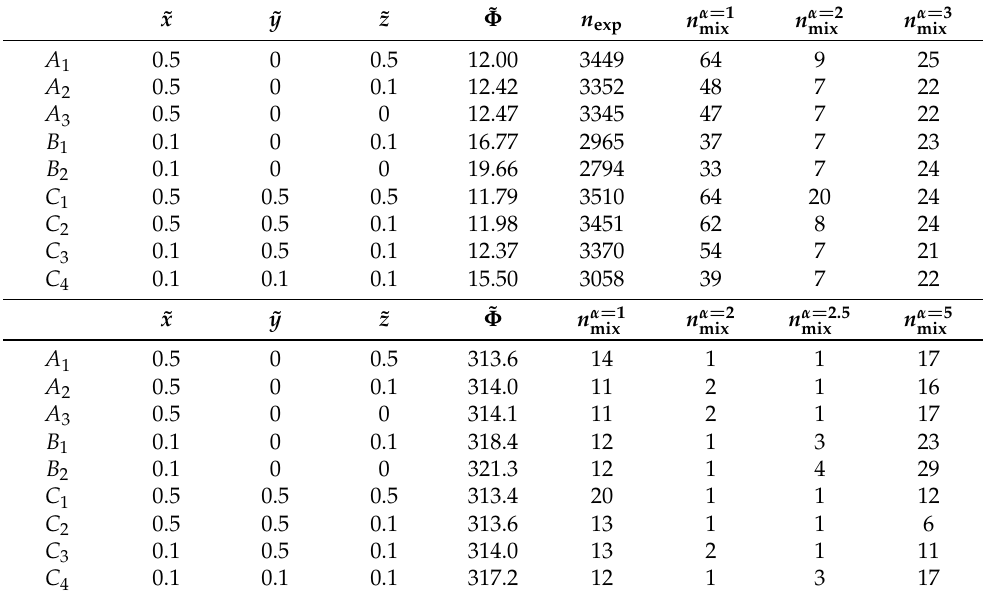
Table 2. Rescaled potential ˜ Φ and the corresponding numbers n exp and n mix of terms in the series sum at nine points for ˜ λ eff = 1 (top chart) and ˜ λ eff = 5 (bottom